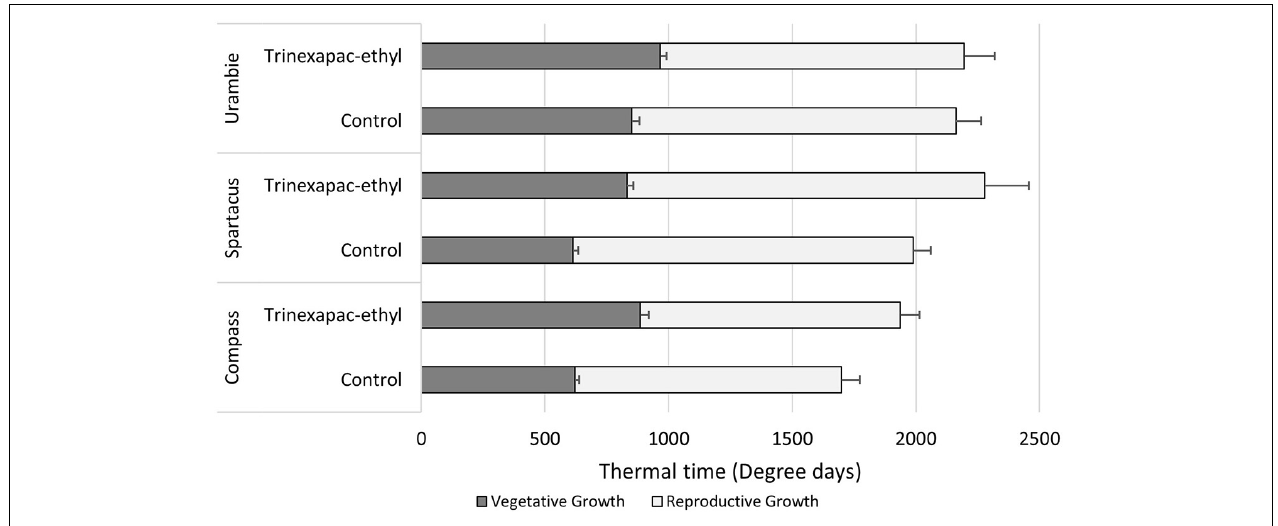
FIGURE 5 | The amount of thermal time accumulated during the vegetative (sowing to GS31) and reproductive (GS31* to GS60) growth phases under short days. The variety × PGR interaction is shown with different varieties and their respective differences that trinexapac-ethyl had on development in comparison to the control. Error bars represent one standard error of the mean difference for the time to GS31 and GS60 respectively. *GS31 was used as a proxy for the start of rapid inflorescence development, but not necessarily the very beginning of reproductive